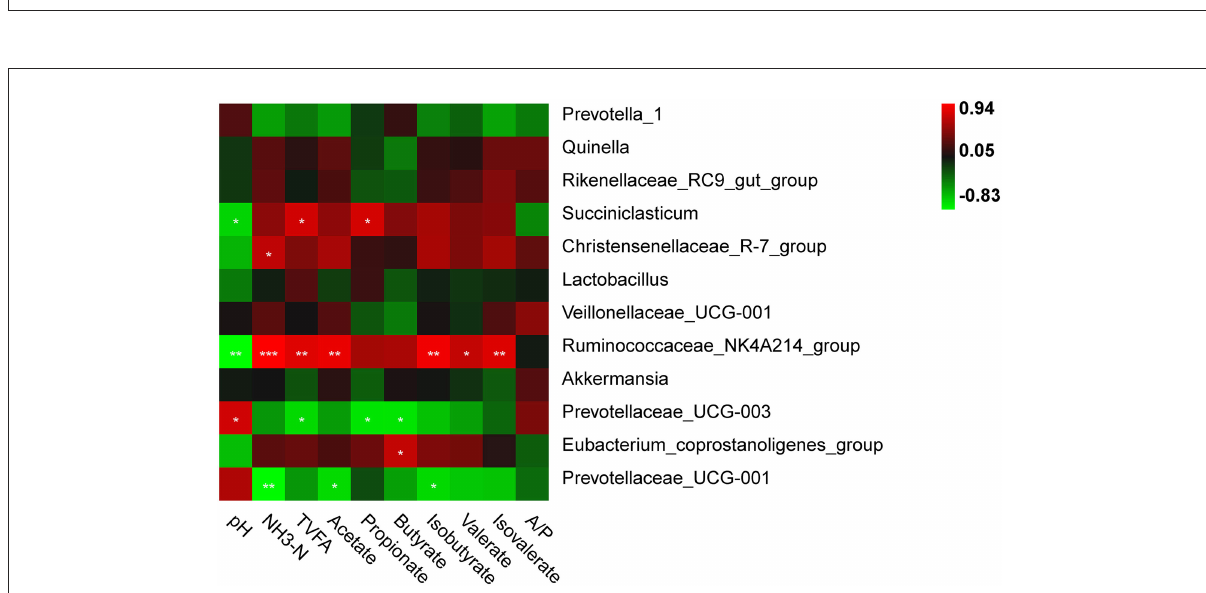
FIGURE4 Correlation between the relative abundances of rumen bacteria and fermentation parameters. “*”, “**”, and “***” indicate the significance level at 0.05, 0.01 and 0.001, respectively.